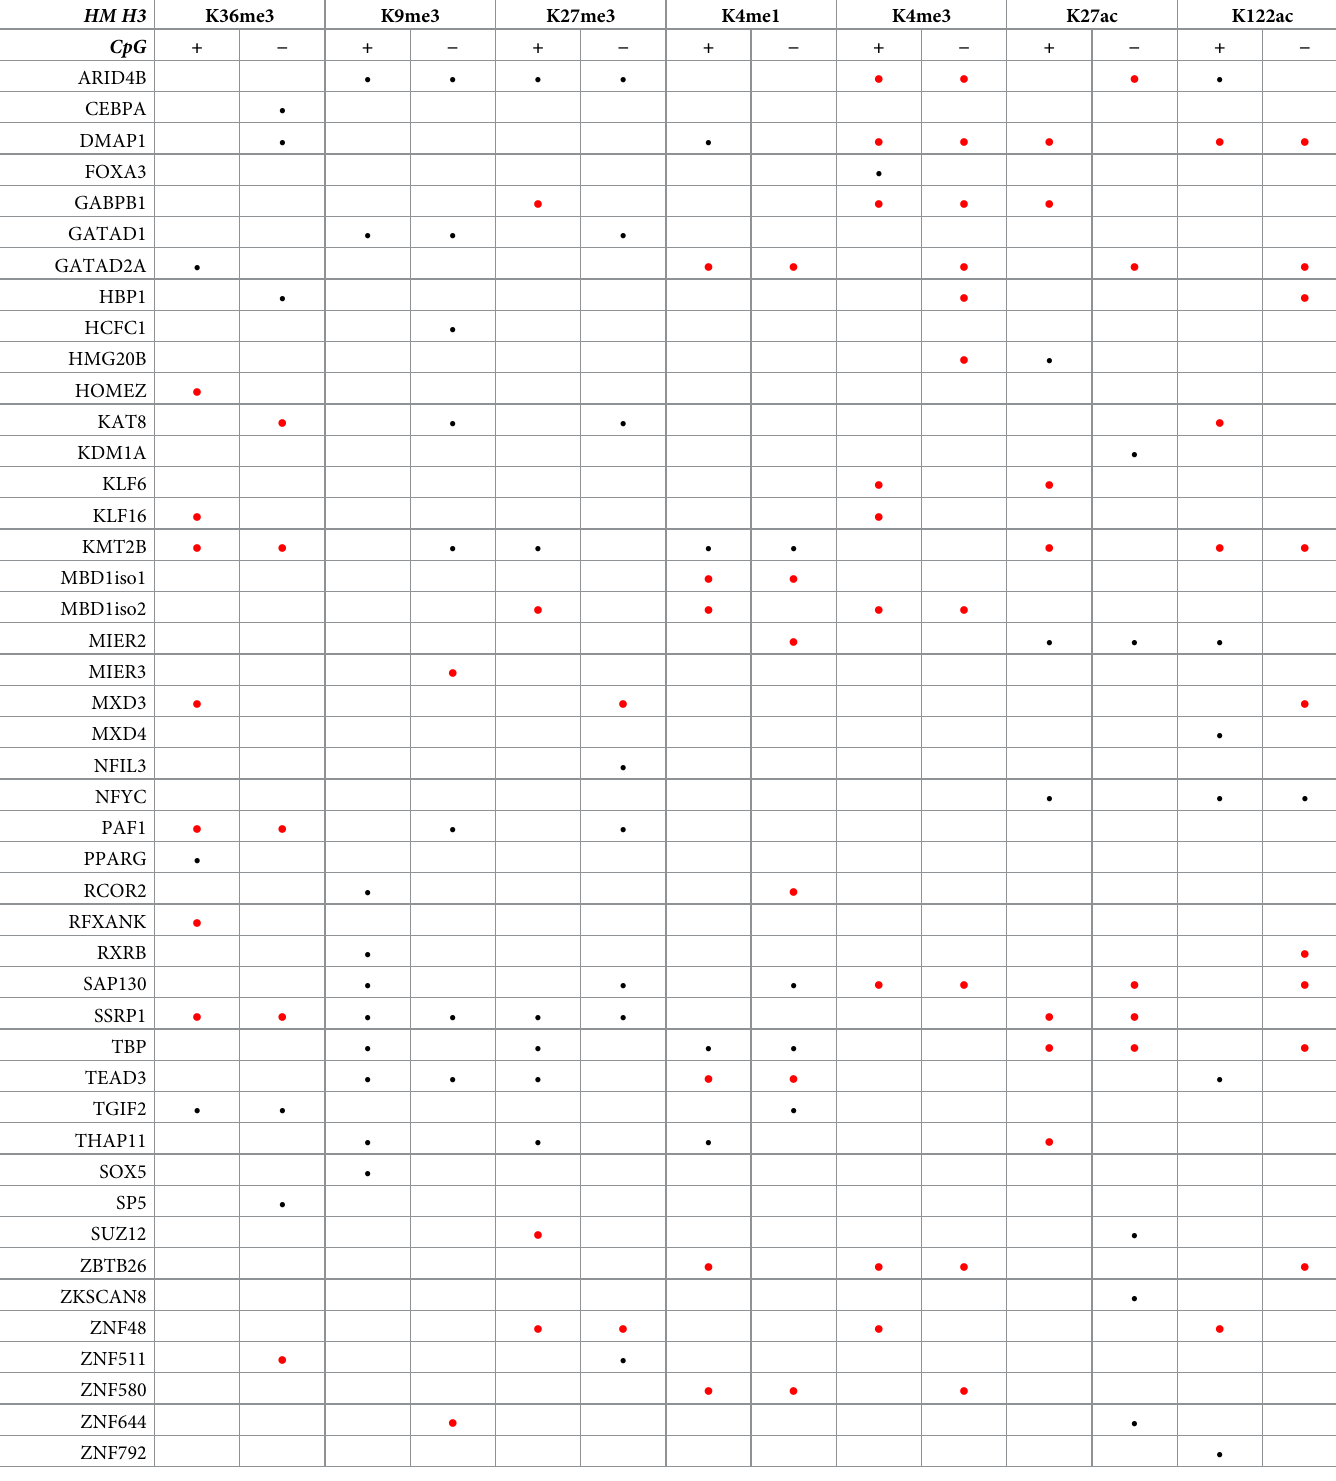
Table 1. Overview of the top 10 TFs found significant in HepG2 models. Positive and negative associations, derived from the coefficients, are indicated by red and black dots, respectively. HM H3